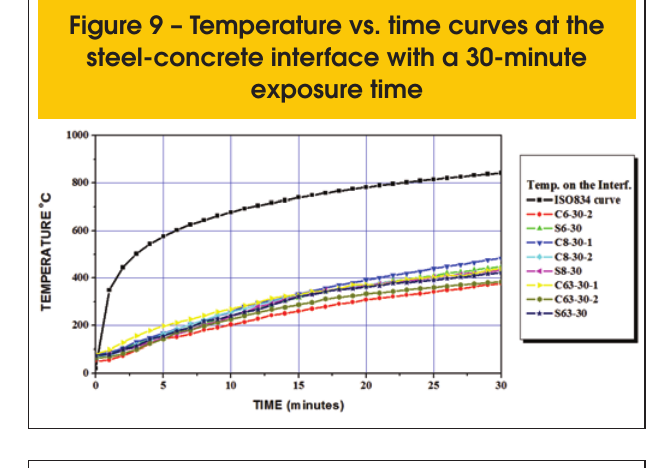
Figure 10 – Temperature vs. time curves in the concrete core with a 30-minute exposure